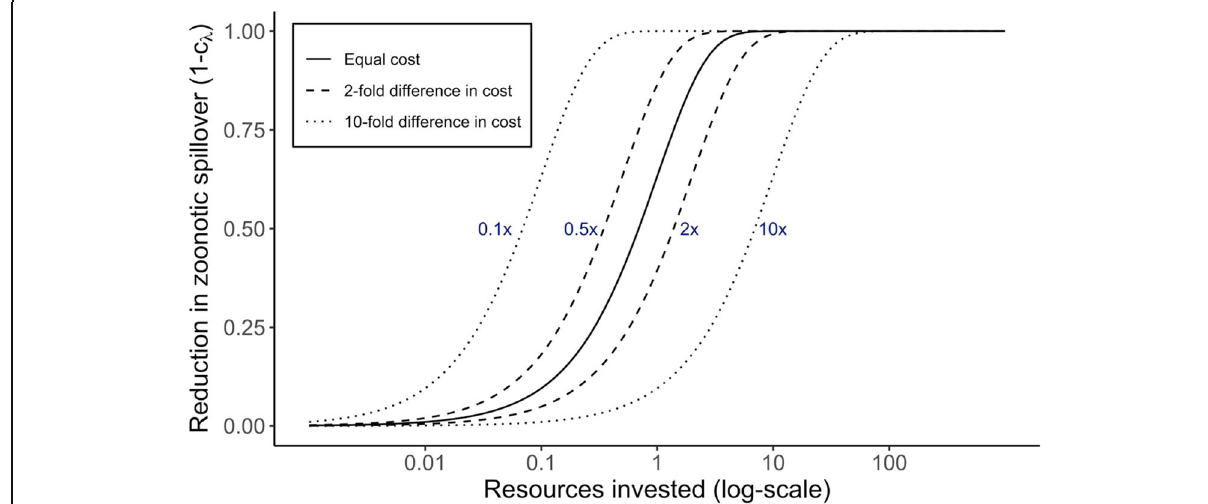
Fig. 2 The cost function for control measures. The solid black line indicates equal cost between implementing spillover control and reducing human-to-human transmission. The x-axis shows an arbitrary scale of resource investment. The dashed and dotted lines show a 2-fold and 10- fold difference, respectively, in the costs of the two control measures. Each line is marked by the relative cost of reducing spillover by a given proportion compared to the cost of reducing human-to-human transmission by the same